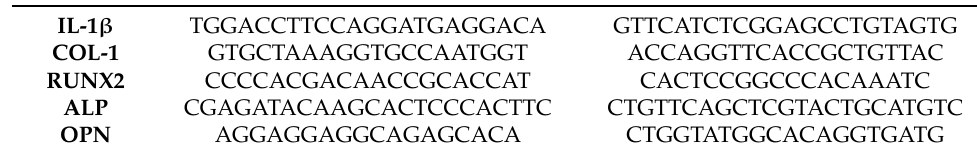
Table 1. The primer sequences of the upstream and downstream primers for these mRNA analyses (5 (cid:48) to 3 (cid:48)